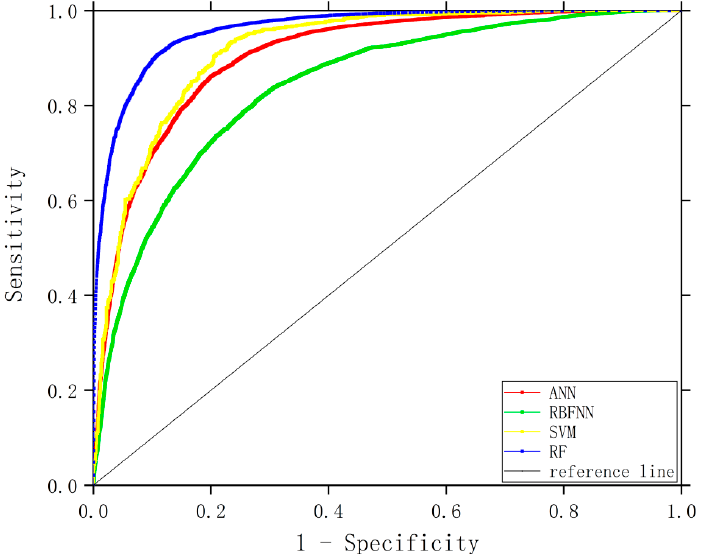
Figure 11. ROC curves of the four models.